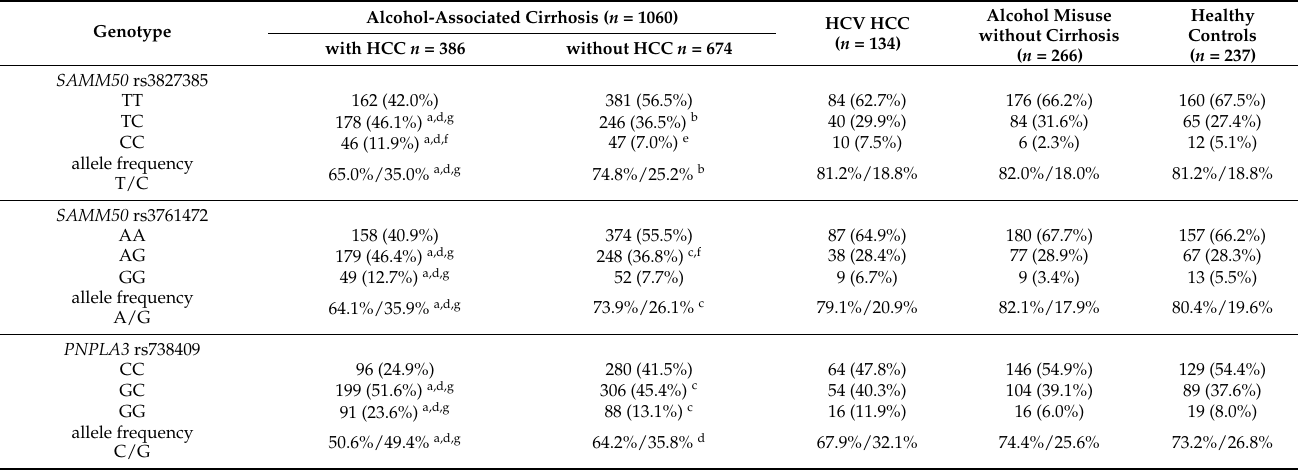
Table 2. Genotype distribution of the SAMM50 and PNPLA3